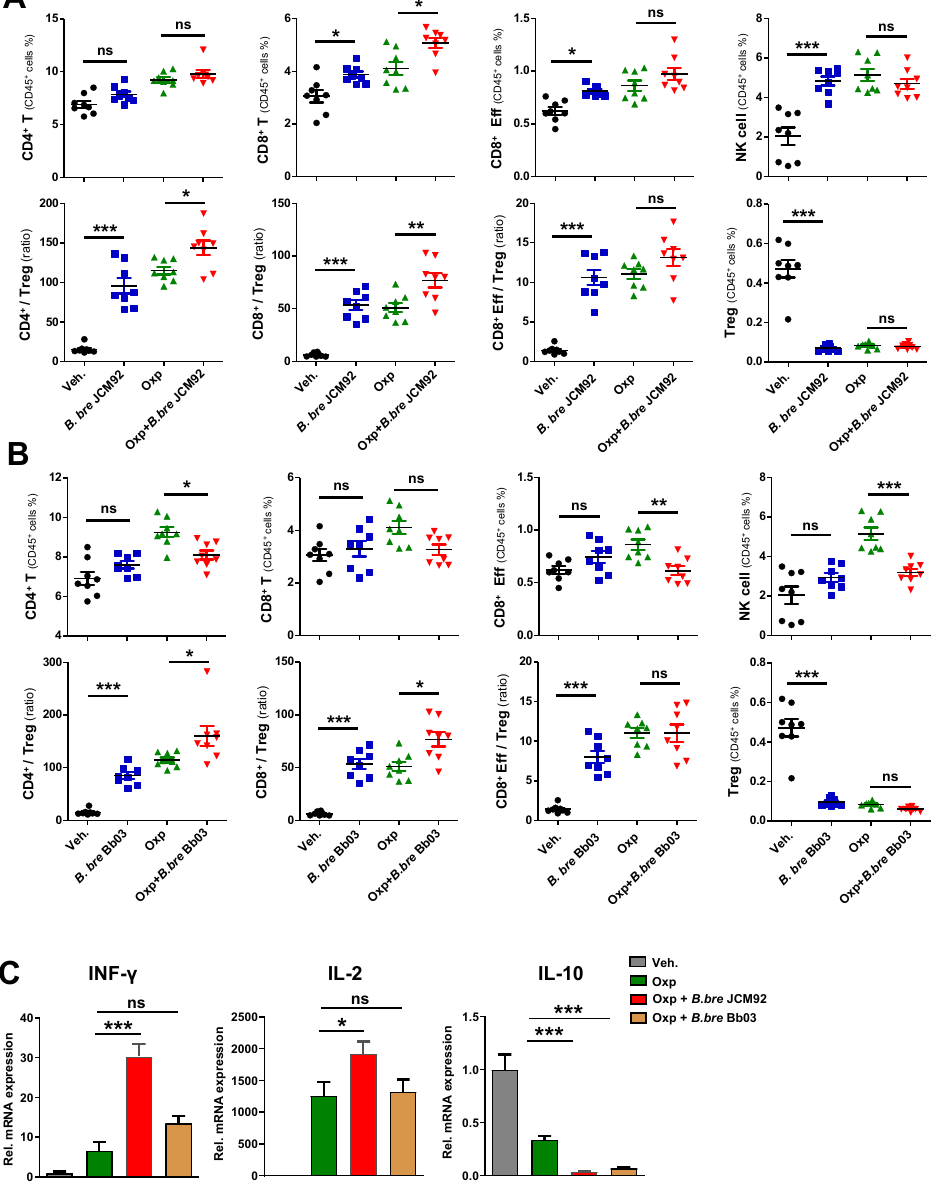
Figure 3. B. bre JCM92 boosts oxaliplatin efficacy by enhancing anti-tumor immunity. ( A , B ) Immune cell profiling of tumor tissue in mice treated with oxaliplatin in combination with B. bre JCM92 ( A ) or B. bre Bb03 ( B ) using flow cytometry analysis. Data are expressed as the means ± SEM. p -values were determined by one-way ANOVA using Tukey’s post-test. ( C ) Expression of intratumoral cytokines in mice treated with oxaliplatin combined with B. bre JCM92 or B. bre Bb03 were measured using qPCR. Data are expressed as the means ± SEM. p -values were determined by one-way ANOVA using Tukey’s post-test within oxaliplatin treated groups. For all graphs, * p < 0.05, ** p < 0.01, *** p < 0.001, and ns, not significant.